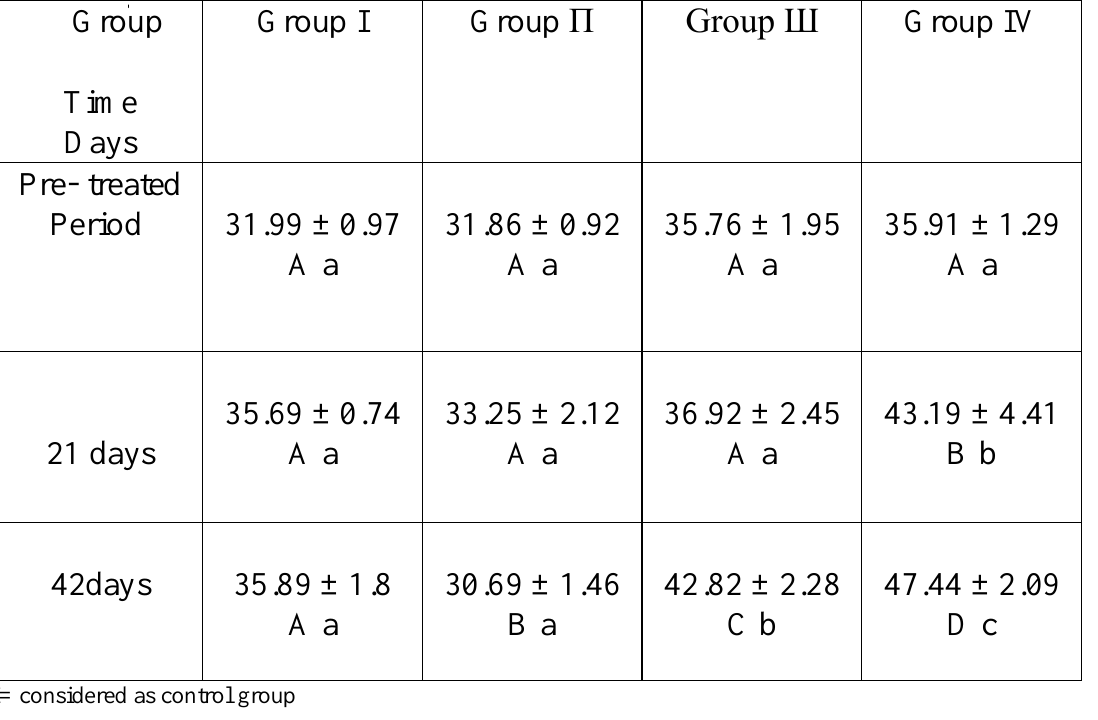
Table (5) Effect of black currant concentrate (Vitis vinfera. L) and vitamin E on serum high density lipoprotein –cholesterol concentration in H2O2 treated